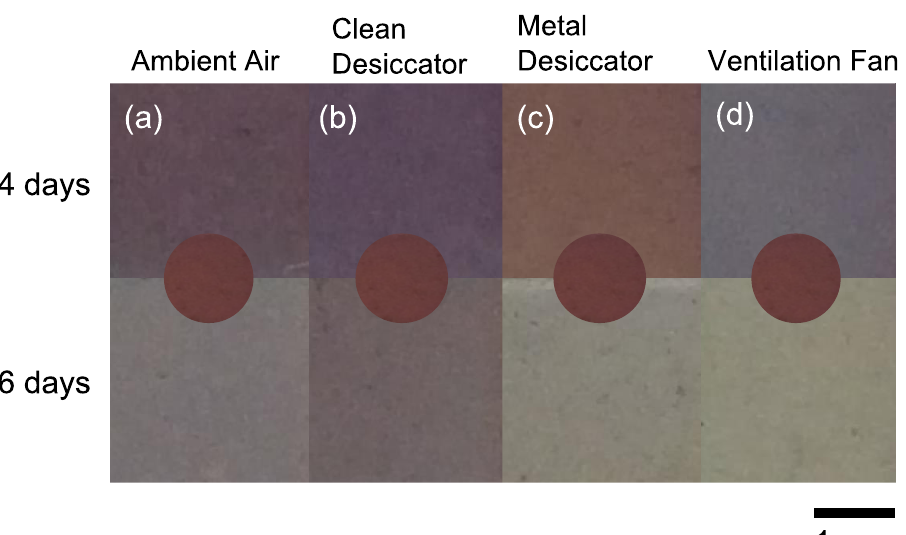
Figure 2. The photographs of Ag/SiO 2 stored ( a ) in ambient air, ( b ) inside the clean desiccator, ( c ) inside the metal desiccator and ( d ) near the ventilation fan. Inset shows the photograph of as-prepared sample for comparison.